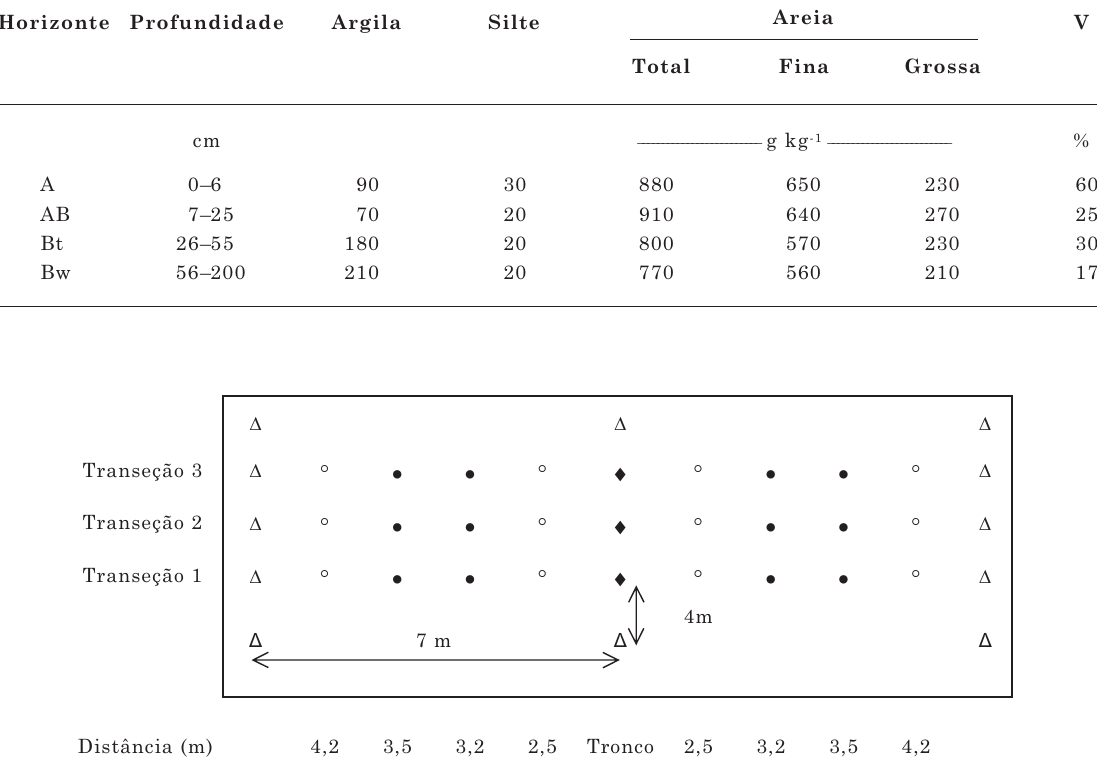
Figura 1. Parcela experimental com três laranjeiras úteis ( ♦♦♦♦♦ ), 12 laranjeiras de bordadura ( ΔΔΔΔΔ ), 12 pontos de amostragem de solo no rodado ( ) e 12 pontos de amostragem do entrerrodado ( ), com a indicação das respectivas distâncias do tronco das laranjeiras úteis, e o espaçamento de 7 x 4 m, entre e dentro das linhas das